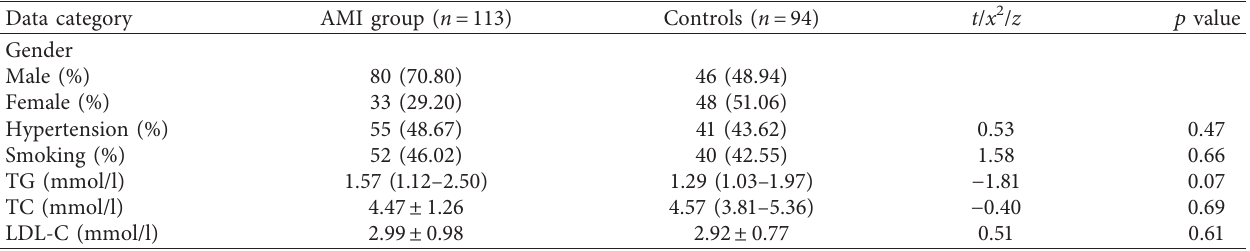
Table 2: Baseline data (which showed no differences between the test and the control